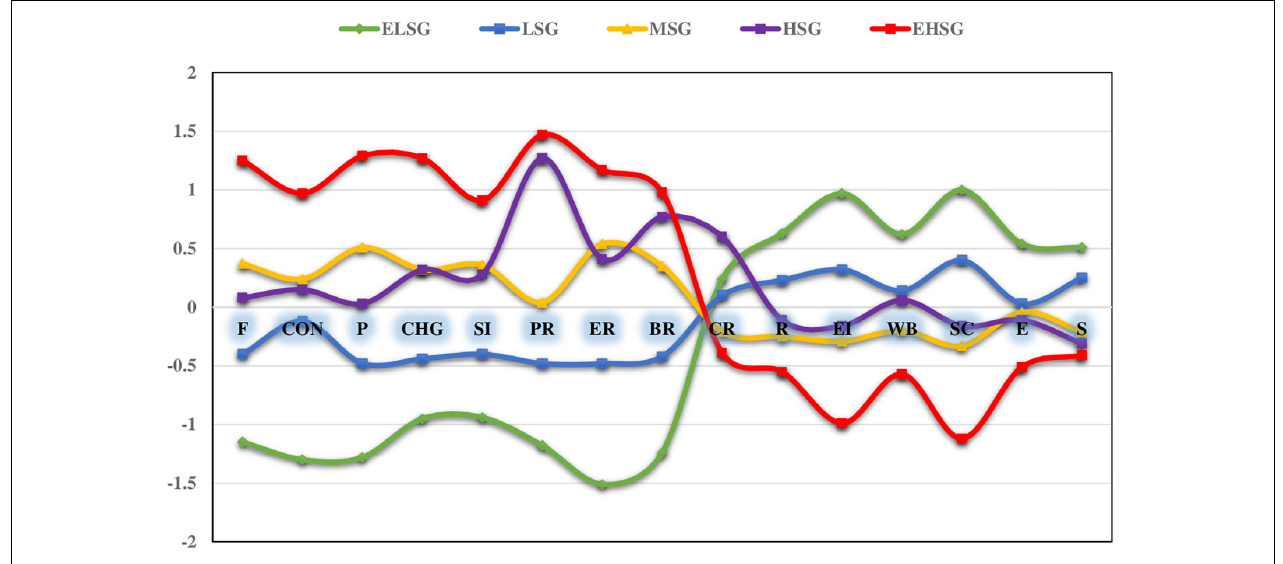
FIGURE 1 | Standardized means of study variables for stress profiles. F, frustrations; CON, conflicts; P, pressures; CHG, changes; SI, self-imposed; PR, physiological reac.; ER, emotional reac.; BR, behavioral reac.; CR, cognitive reac.; R, resilience; EI, emotional intelligence; WB, well-being; SC, self-control; E, emotionality; S,